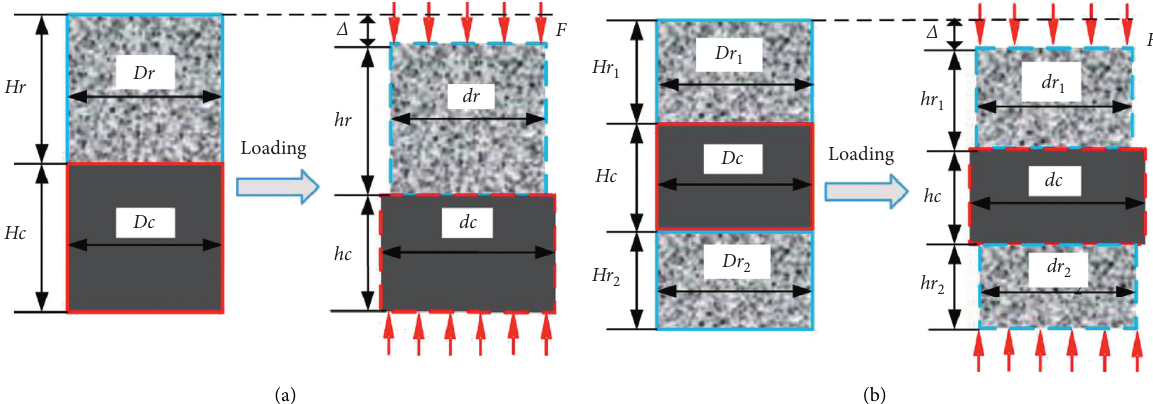
Figure 7: Schematic of deformation process of coal-rock composite models under loading. (a) Two-body combination model. (b) Three- body combination